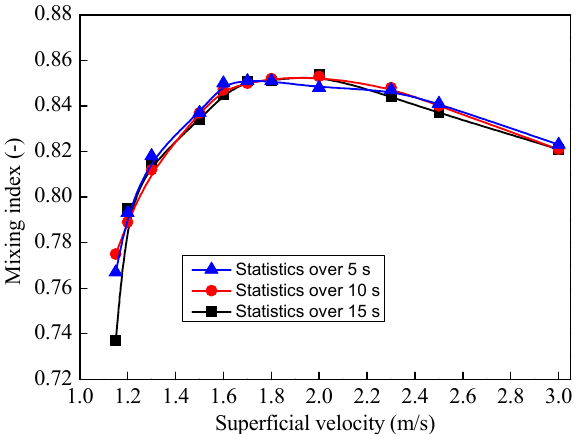
Figure 8. Time-averaged mixing index under different superficial gas velocities.